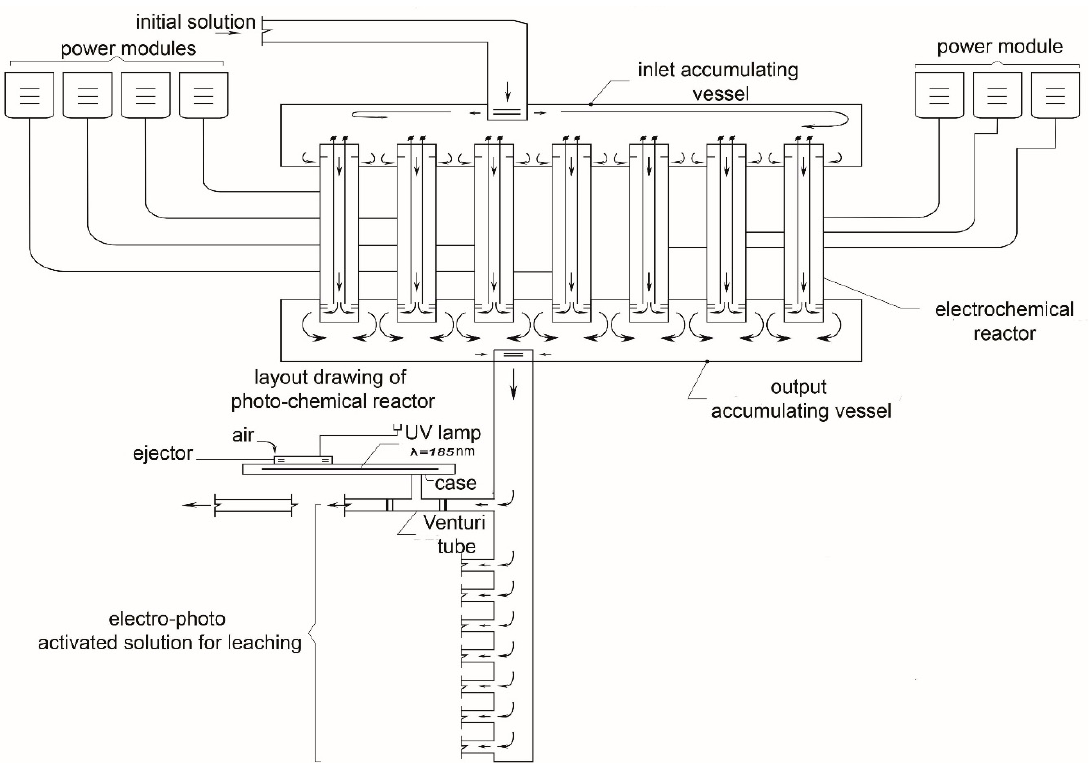
Figure 2. Layout drawing of photo-elecro-chemical reactors.